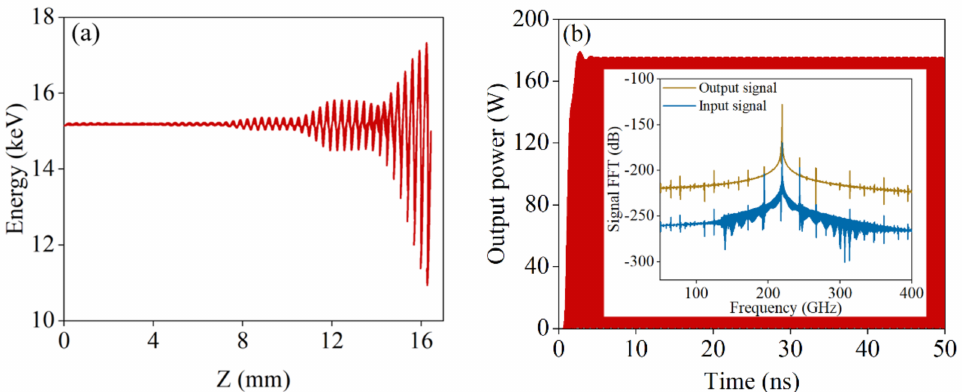
Figure 7. ( a ) The phase-space diagram of the electron beam energy, where it is shown that the electron beam is well-modulated in each cavity. ( b ) Output power versus time. Inset: frequency spectra of the input and output signals. It is shown that the spectrum is pure, and the frequency of the output signal is exactly the same as that of the input